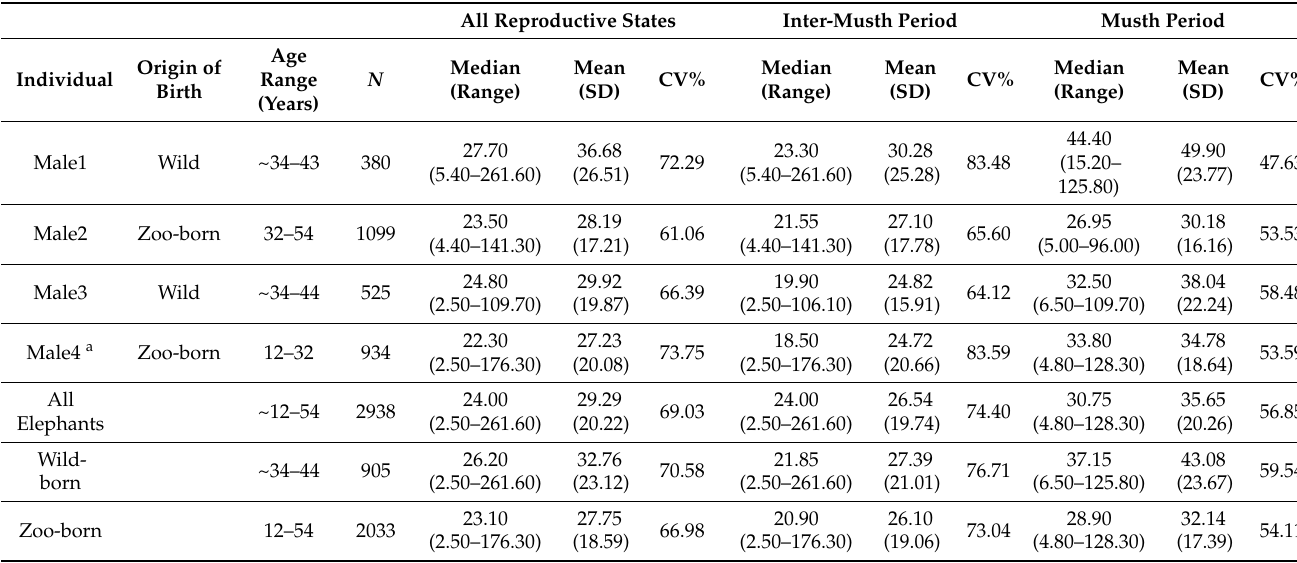
Table 9. Serum cortisol concentration (ng/mL) for males across all reproductive states and during periods of musth and inter-musth. Individual, birth origin, age range during study, number of samples measured for serum cortisol, and concentration median, range, mean, standard deviation (SD), and coefficient of variation